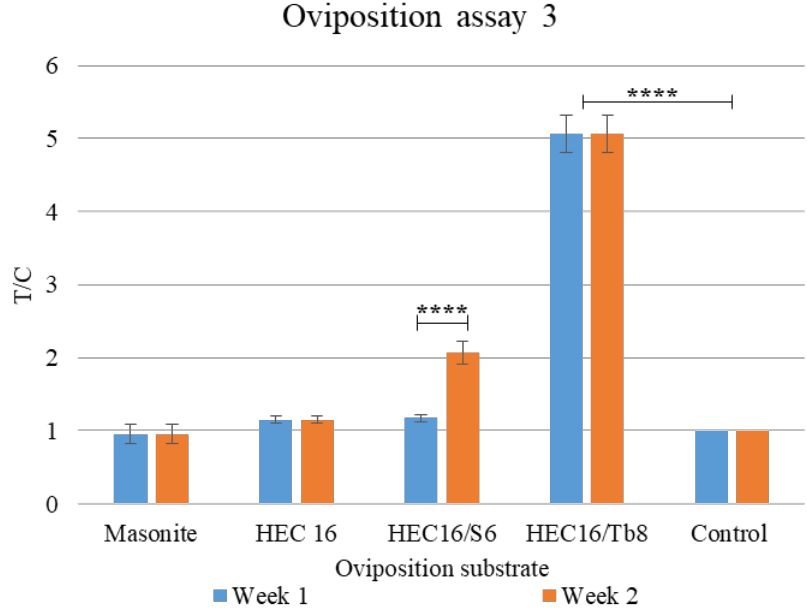
Figure 4. Oviposition assay 3: Substrate preference between masonite and all best performing gels in oviposition assay 2. HEC16 represents the best performing in pH and salinity assays, pH = 6.5, and salinity < 1%. Absorbing paper was used as control. T/C = eggs on sample (T)/eggs on control (C, absorbing paper). All the tests were carried out at 25 °C and 80% of relative humidity (RH). Statistical analysis legend: p < 0.0001 = ****.